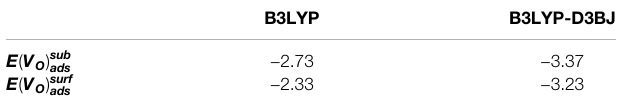
TABLE 6 | Adsorption energies of D -glucose on cluster-containing subsurface, E(V O ) sub ads , and surface, E(V O ) surf ads , oxygen vacancy calculated at B3LYP and B3LYP-D3BJ level of theory. Values are given in